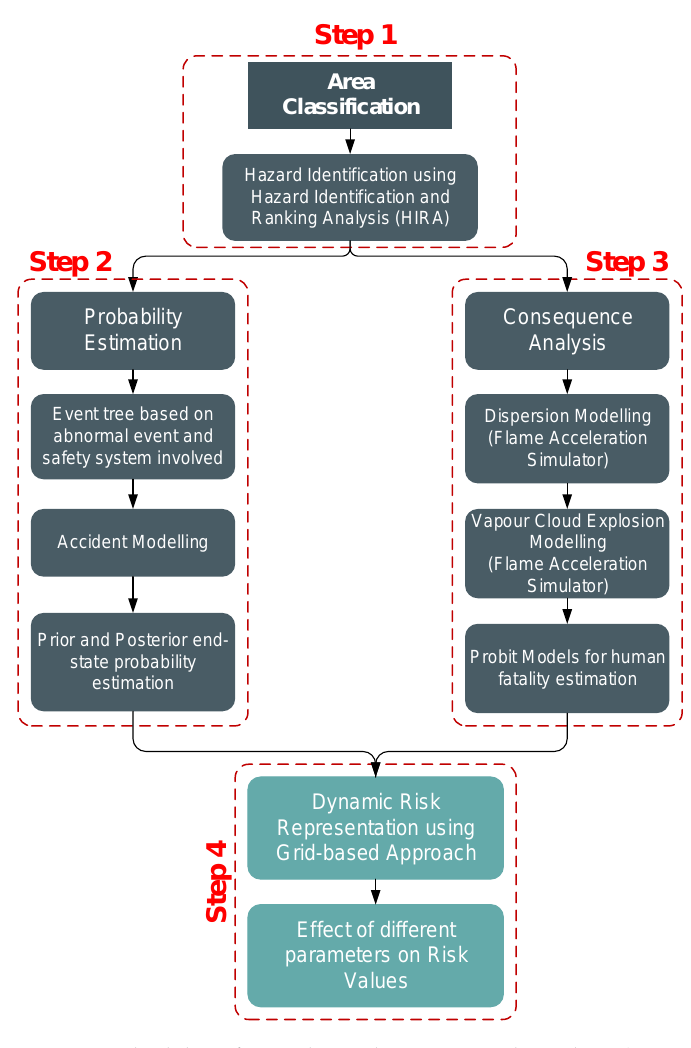
Figure 1. Methodology for Grid-Based Dynamic Risk Analysis (GDRA).